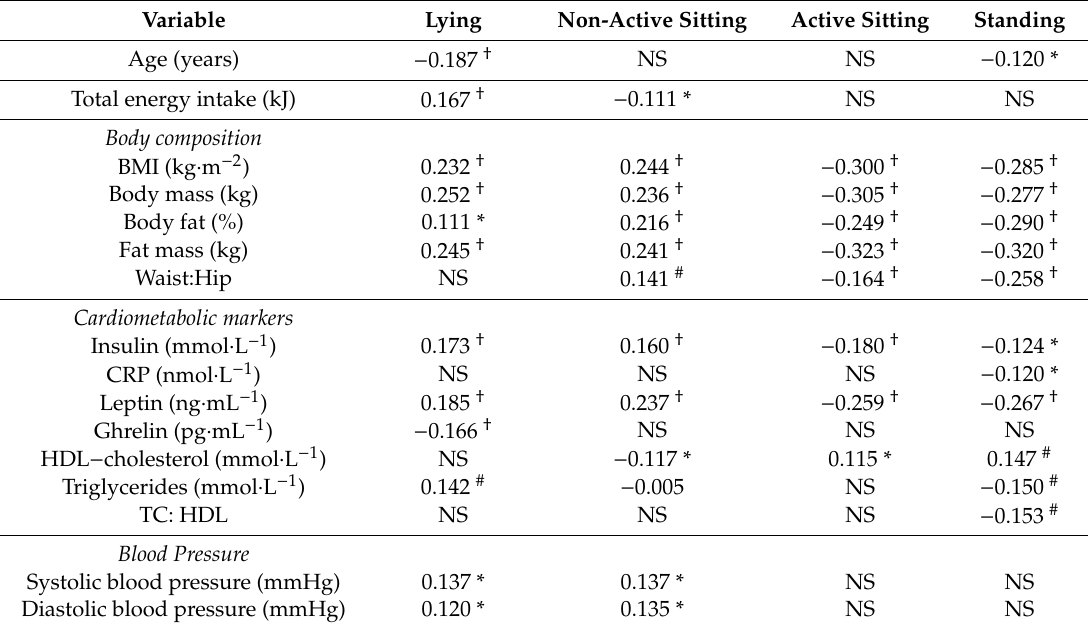
Table 4. Pearson’s correlations of sedentary behavior with anthropometric variables and